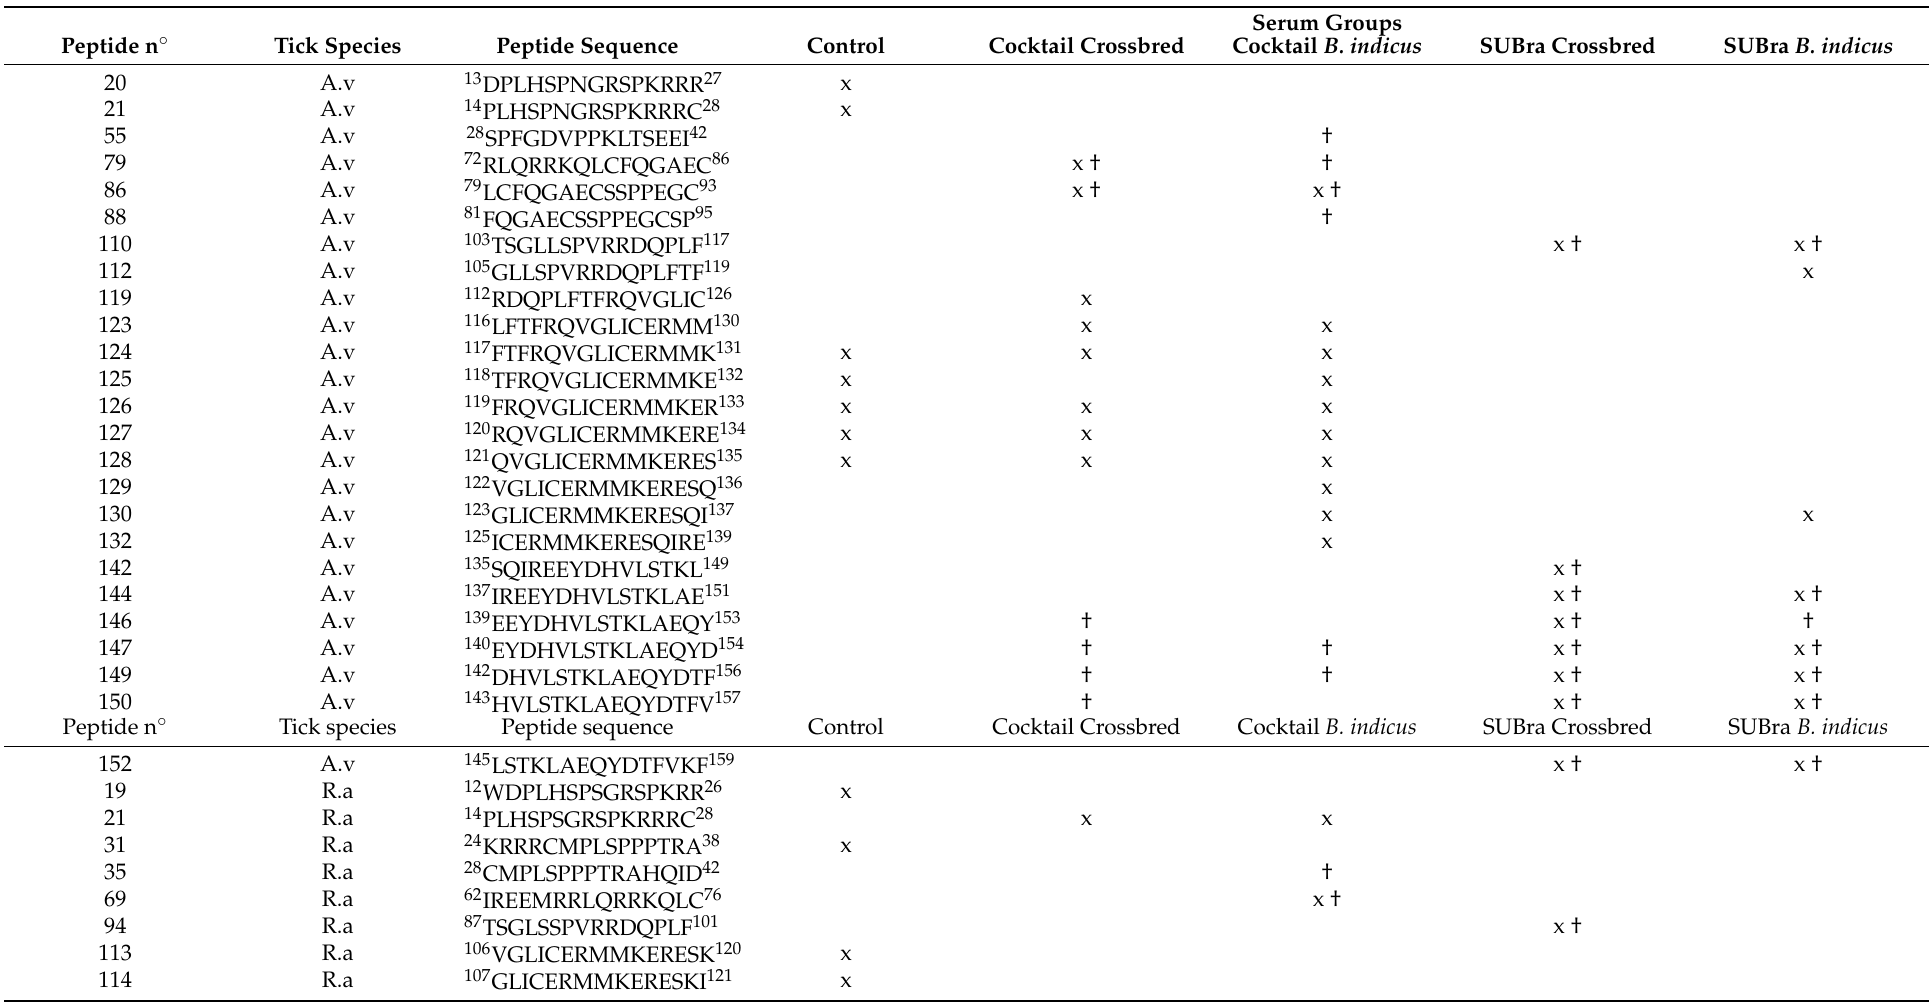
Table 1. SUB overlapping peptides from three different tick species identified as reactive and protective in each of the study